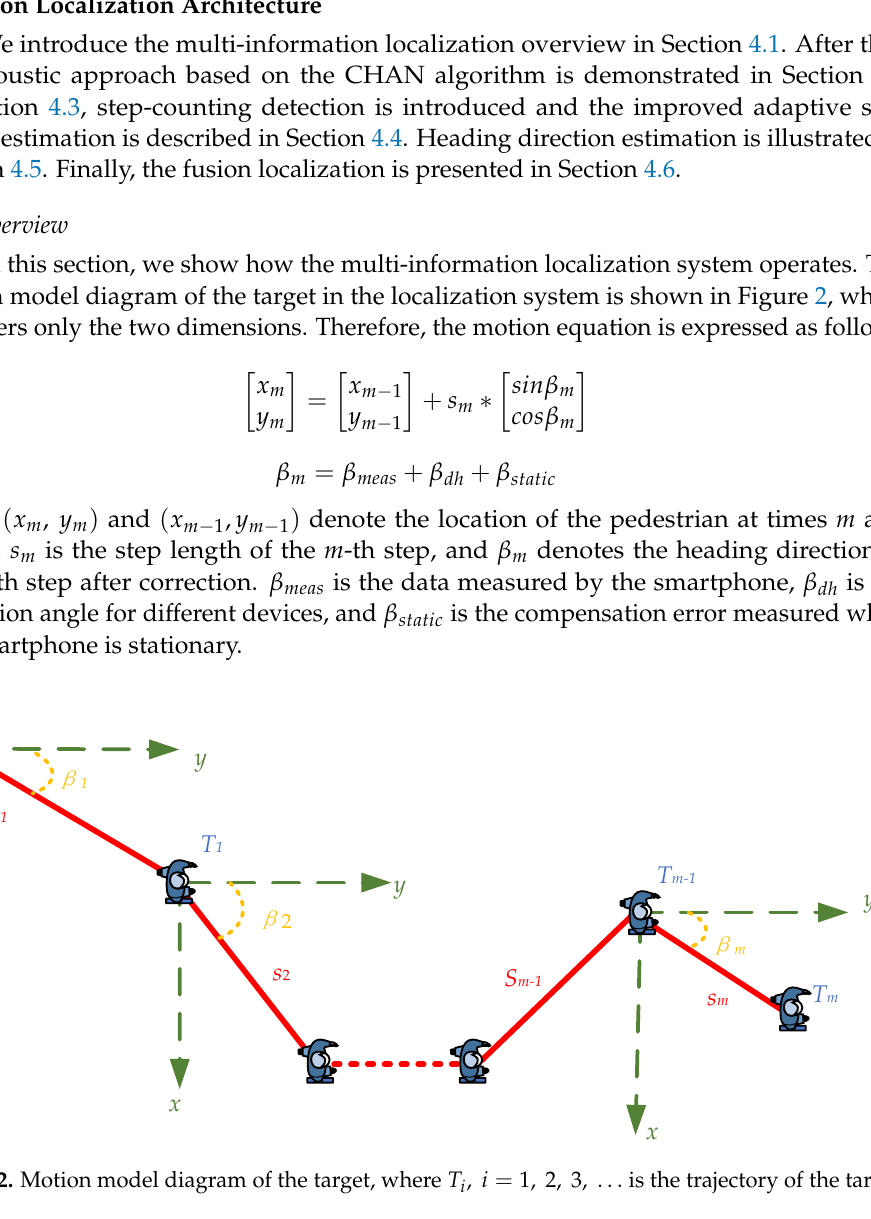
Algorithm 1: Procedure of fusion